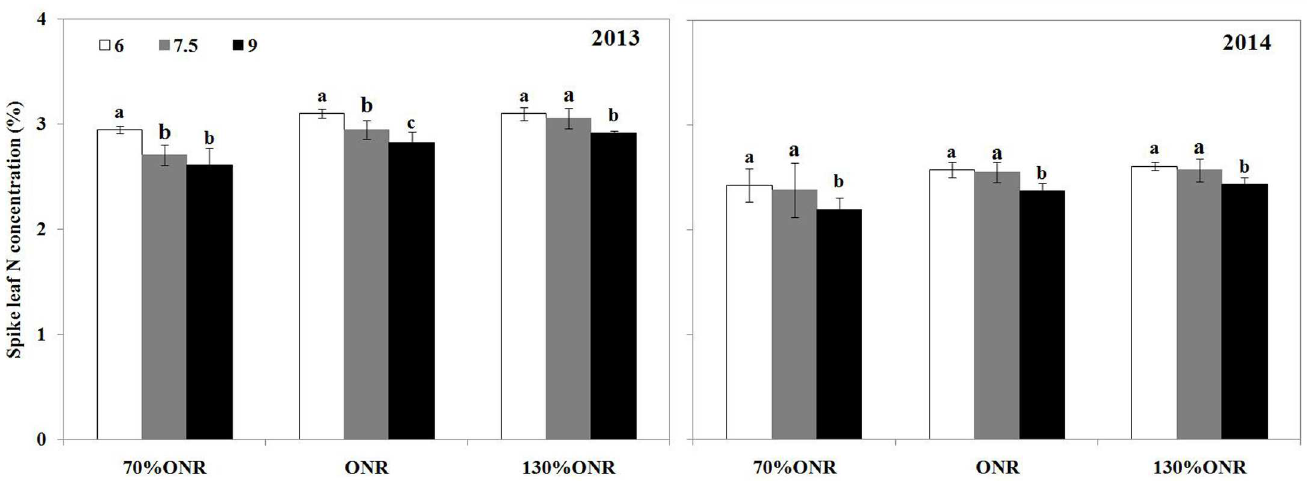
Fig 3. Maize spike leaf N concentration as affected by three plant densities under the 70%ONR, ONR, and 130%ONR N-management schemes at the silking stage during the two-year study. Lower case letters indicatesignificantdifferencesbetweentreatments at the P < 0.05